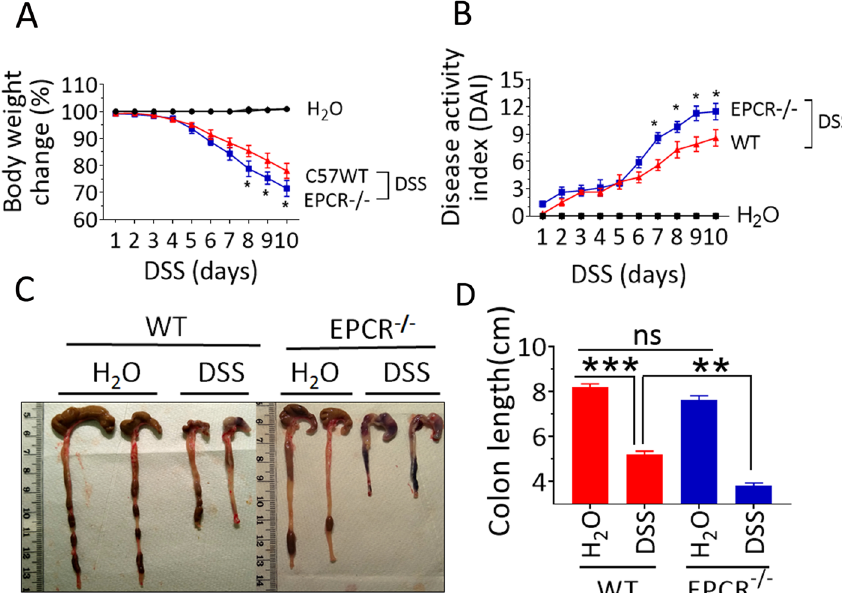
Figure 2. EPCR deficiency exacerbates the DSS-induced colitis in mice: Wild-type and EPCR −/− mice were treated with DSS (2.5% w/v) in the drinking water for 10 days. The disease activity index (DAI) was monitored during the course of colitis based on body weight loss, diarrhea, and fecal blood. The body weight loss ( A ) and DAI ( B ) were calculated as described in Methods. ( C ) Representative pictures of the colon from the control (H